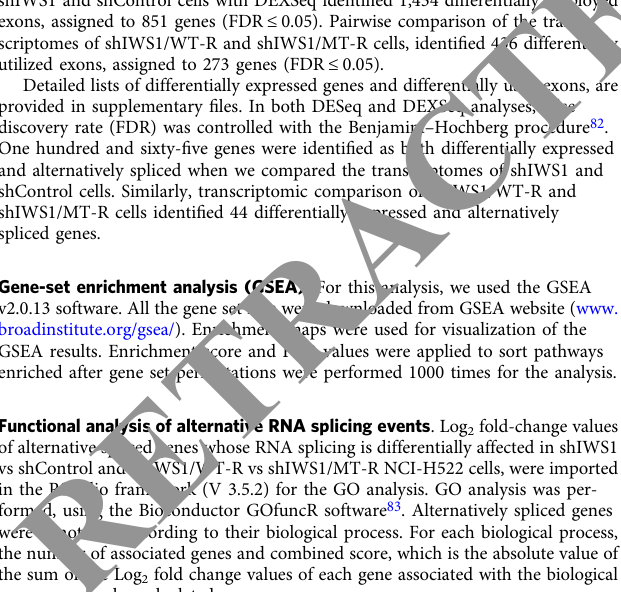
Supplementary Table 1. Western blot images were captured, using the Li-Cor Fc Odyssey